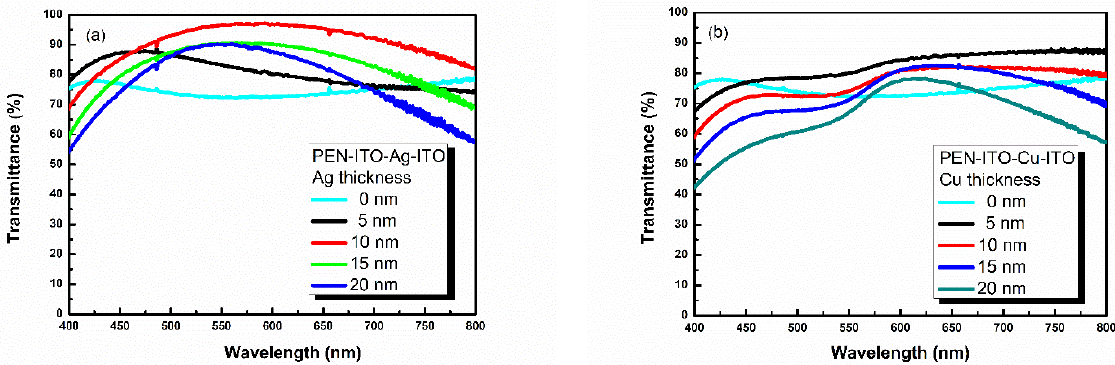
Figure 6. Optical transmittance of the ( a ) IAgI and ( b ) ICuI films as functions of the Ag and Cu thickness on PEN substrate.